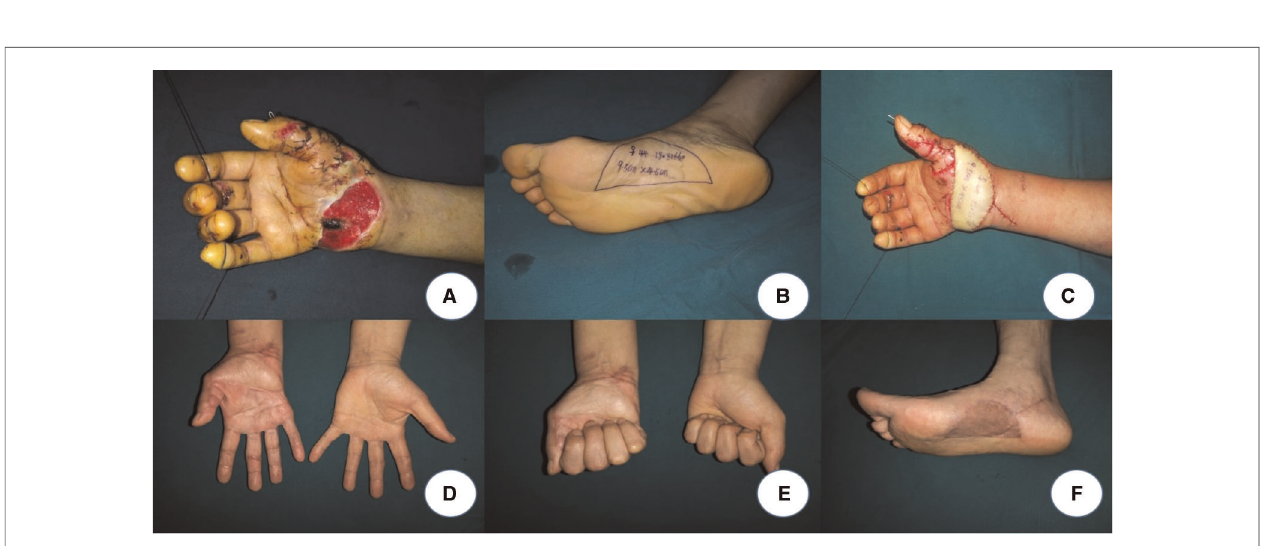
FIGURE 2 | A : Soft-tissue defect on the right hand. B : Design of the fl ap. C : Coverage of the fl ap. D – F : A 30-month follow-up after the